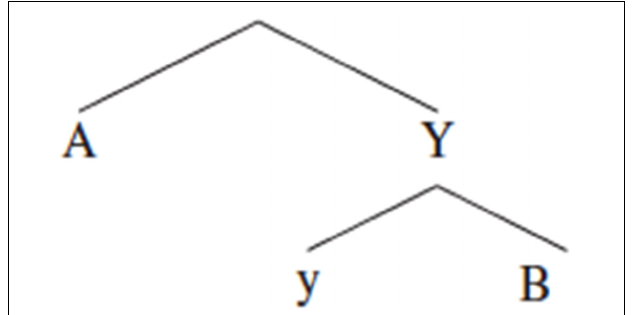
FIGURE 8 | Representation of C-command between A and